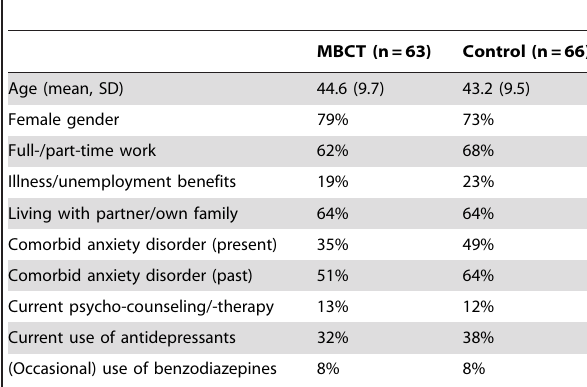
Table 1. Baseline demographic and clinical characteristics in each